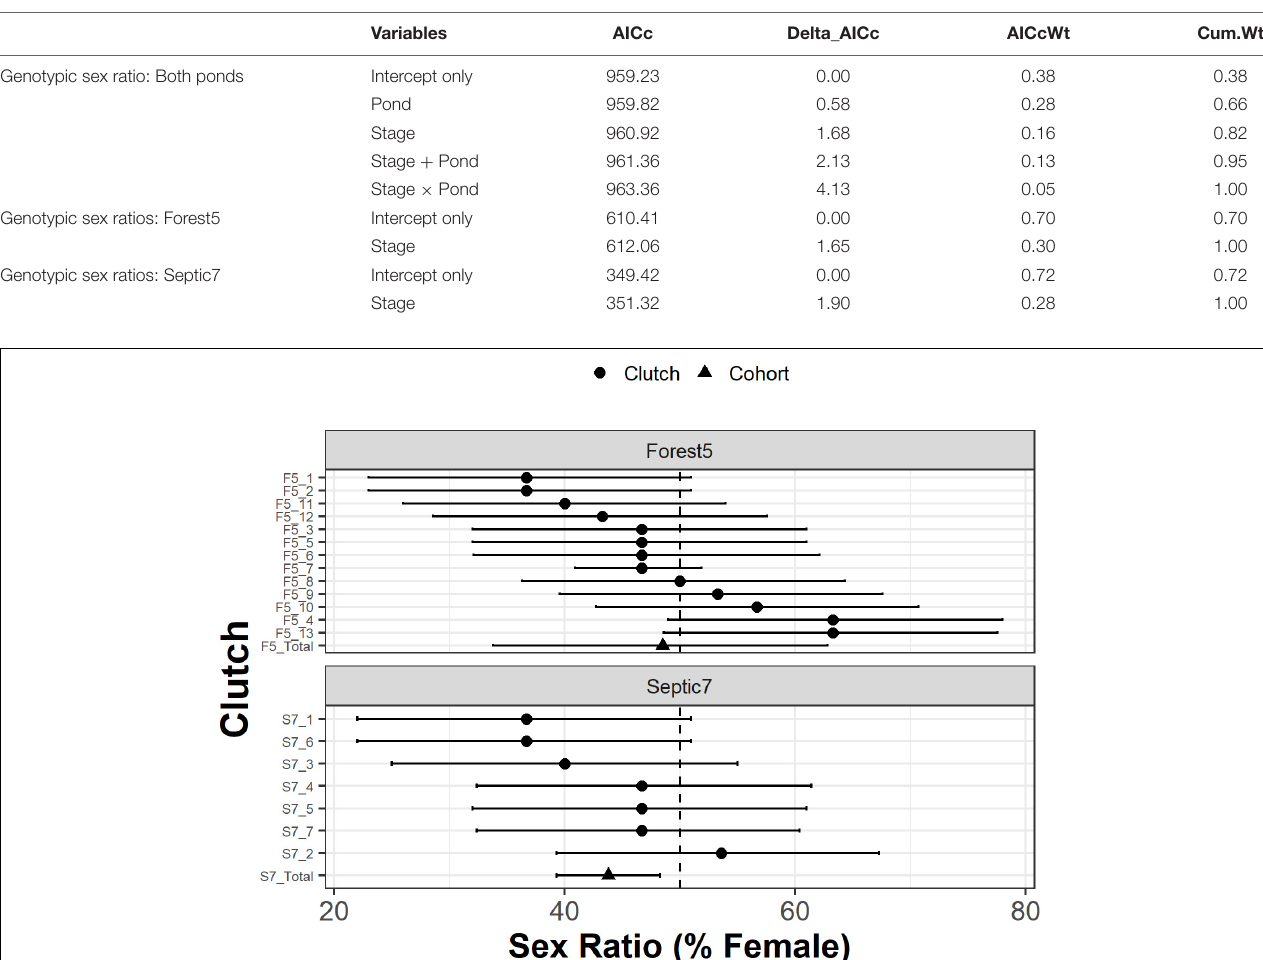
TABLE 1 | Analysis of models of genotypic sex ratio across developmental stages (a proxy of sex-biased mortality) and between ponds using individual sample as the unit of measurement. Variables AICc Delta_AICc AICcWt Cum.Wt